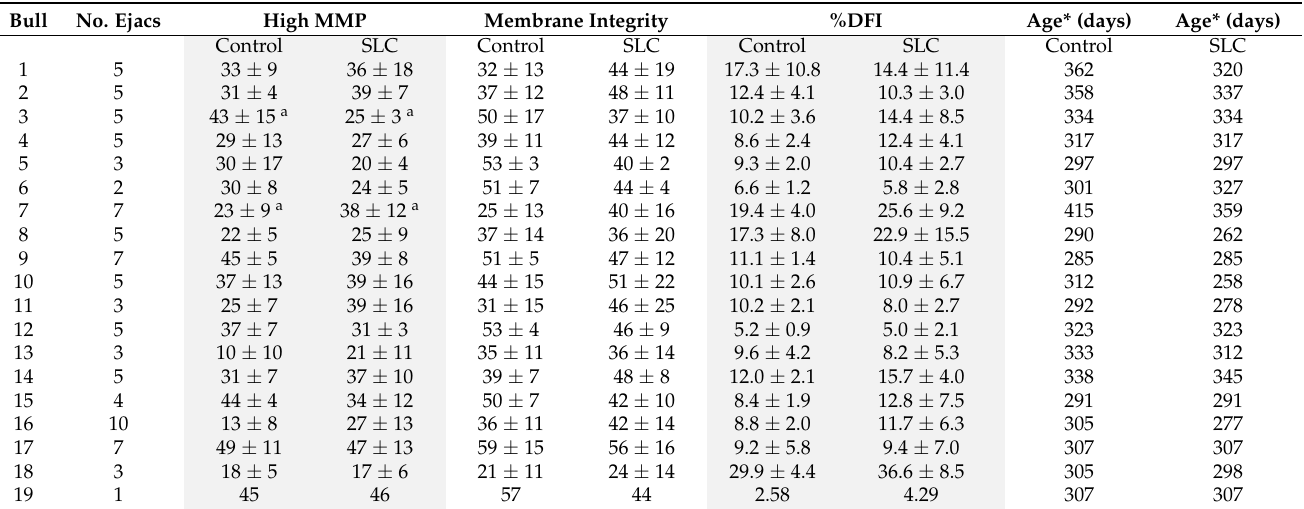
Table 1. High mitochondrial membrane potential; membrane integrity and DNA fragmentation index (unadjusted means ± SD) for control and SLC-selected sperm samples (n = 91).